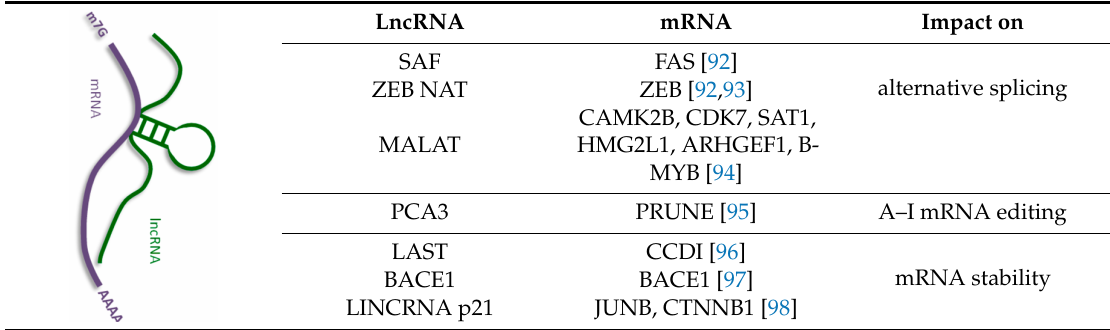
Table 3. Some examples of lncRNA–mRNA